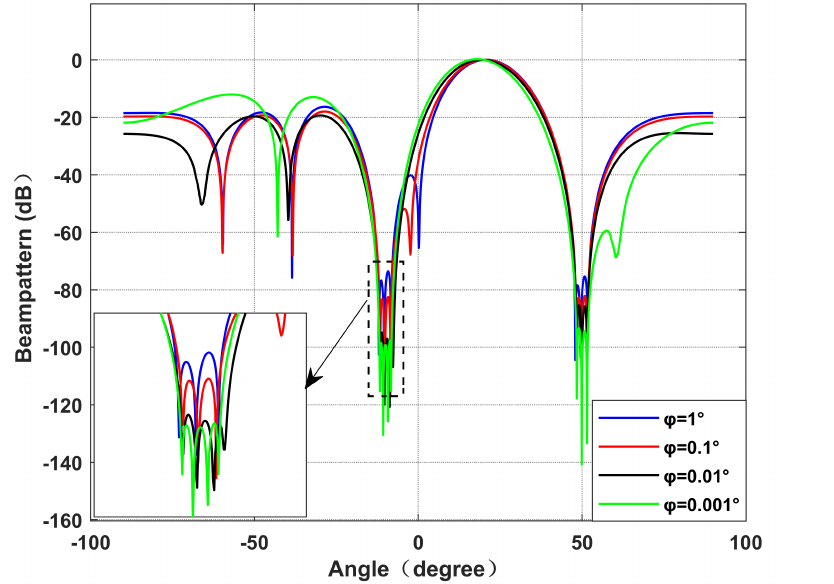
Figure 5. Beamforming diagram with different values of ϕ . Simulation 2.